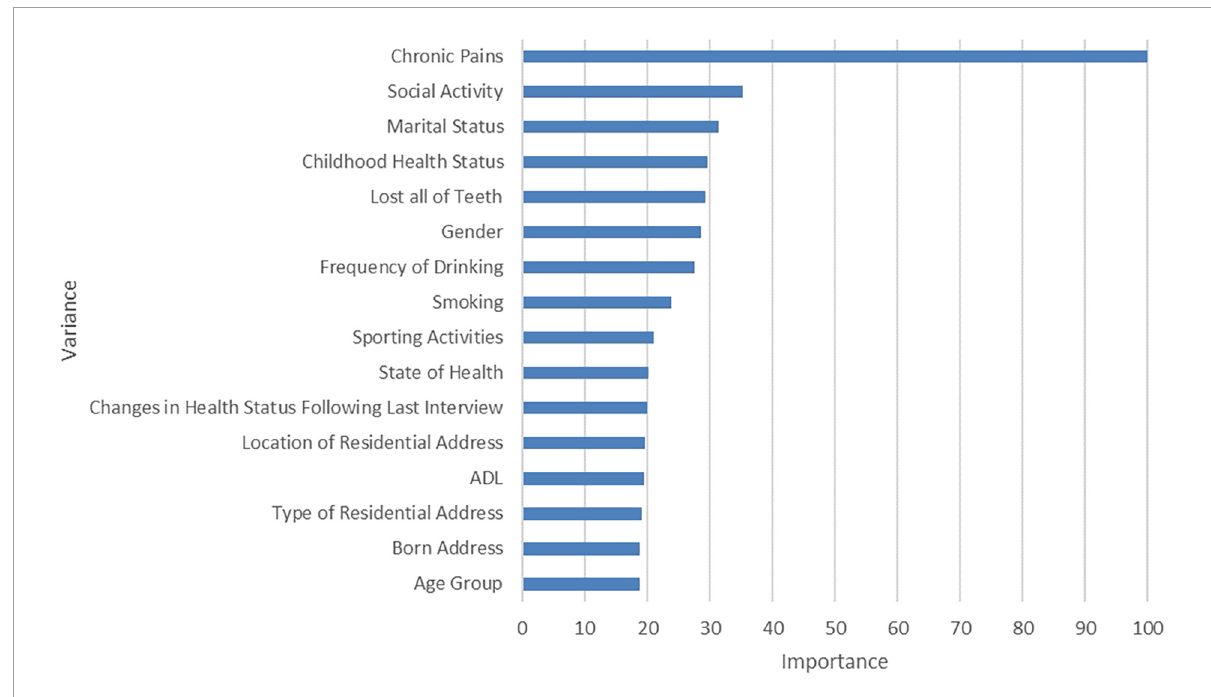
FIGURE2 Permutation importance of features in random forest